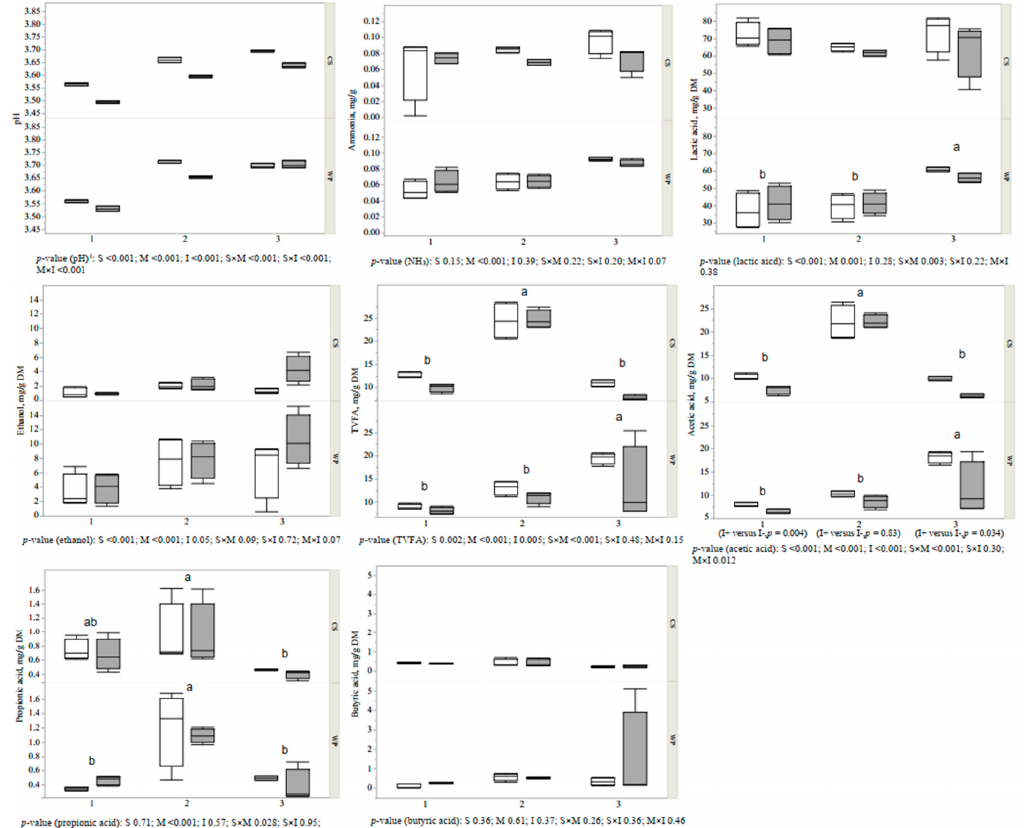
Figure 2. Effects of substrate, time after ensiling, and inoculation of Lactobacillus plantarum on fermentation variables of silage (n = 4). CS, sweet corn stover; WP, sweet corn whole plant. Sampling time points (months after ensiling) are scattered along the x axis. Boxes filled in gray indicate inoculation with Lactobacillus plantarum . Horizontal lines inside the boxes indicate the median, upper and lower lines of boxes indicate upper and lower quartiles, respectively, and whiskers indicate the maximum and the minimum. p -values for the following effects are provided in legends below the graph: M, Months after ensiling; S, substrate; I − , not inoculated; I+, inoculated; S × M; interaction between substrate and month; S × I; interaction between substrate and inoculation; M × I; interaction between month and inoculation. ab Unlike-lower case letters within a substrate differ ( p < 0.05).